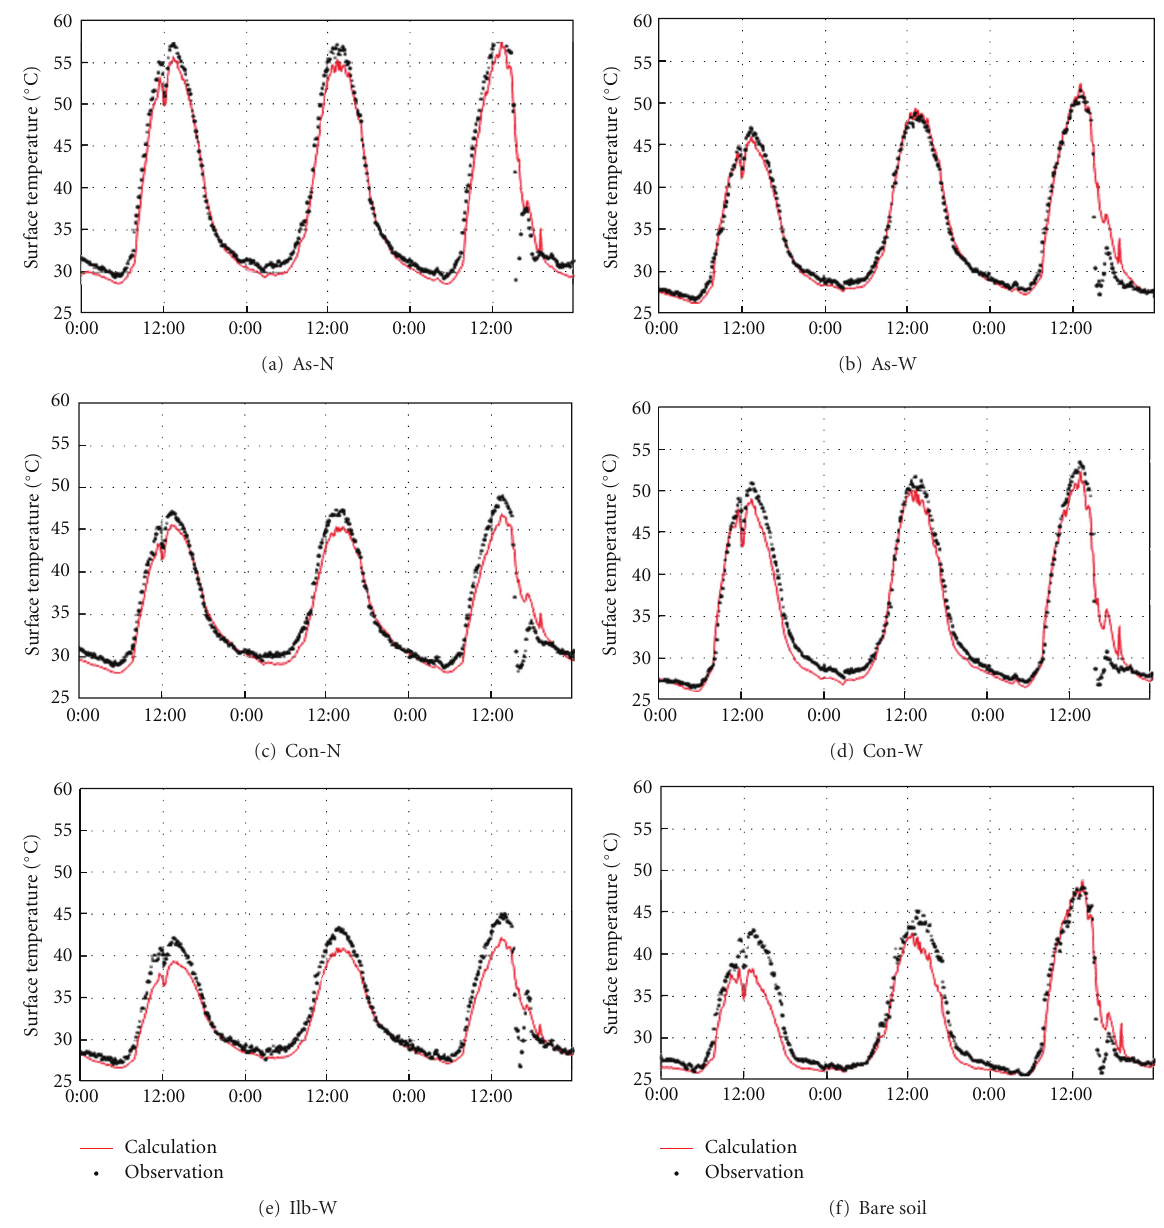
Figure 13: Calculated and observed values of surface temperature for several pavement surfaces on August 3 to 5, 2005. Table 8: Values of sensible heat flux (W/m 2 ) estimated for each pavement surface on August 3 to 5, 2005. Pavement As-N As-P As-W Grass Maximum